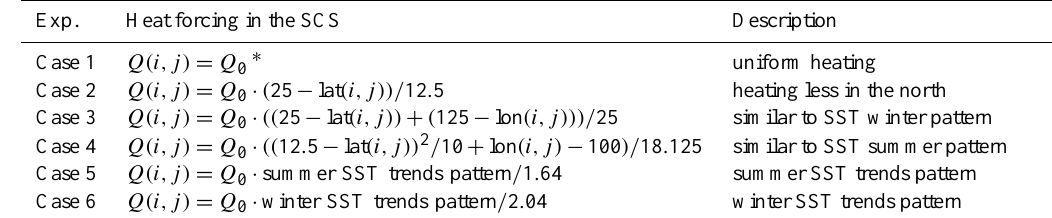
Table 1. The heat forcing Q at each grid for cases 1–6. Exp.